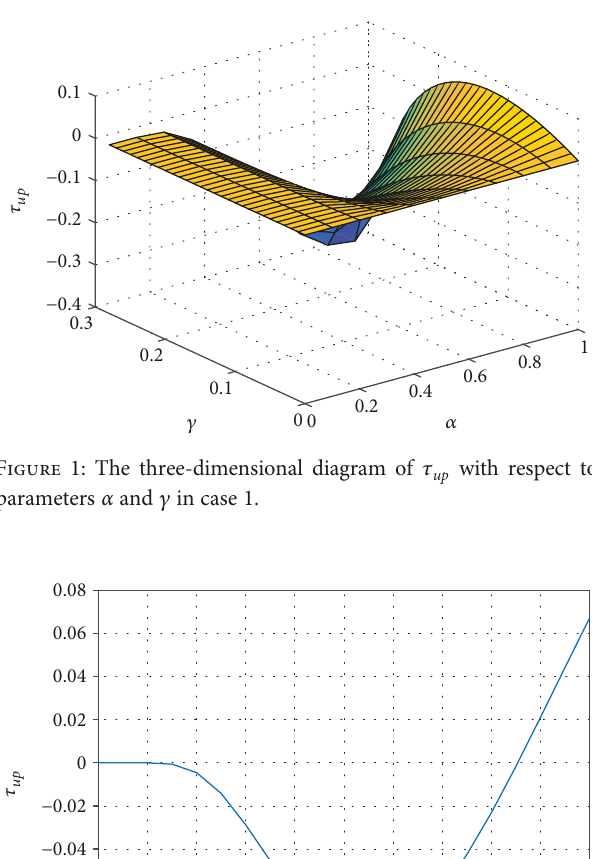
Figure 2: The relationship between τ